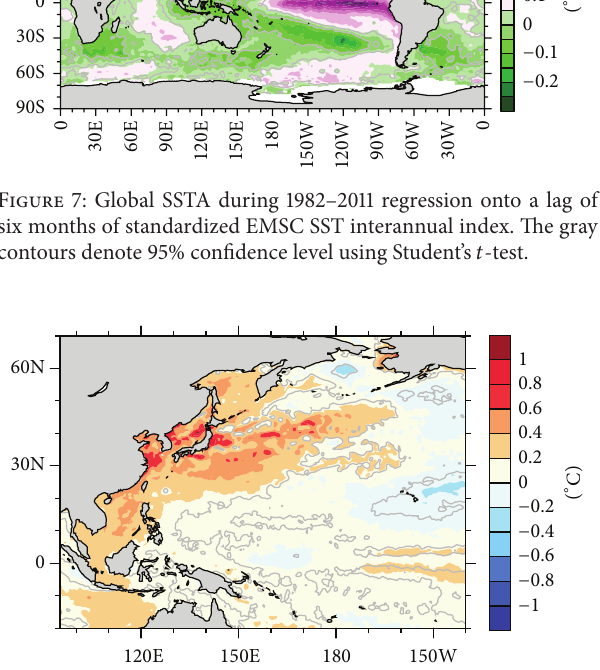
Figure 8: Northwestern Pacific SSTA during 1982–1998 regression onto the time series of standardized EMSC SSTA averaged over the whole EMSC. The gray contours denote 95% confidence level using Student’s 𝑡